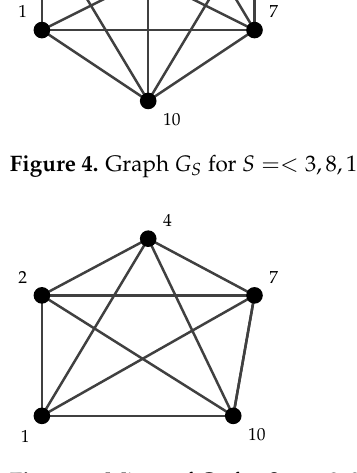
Figure 5. Minor of G S for S = < 3,8,13 >